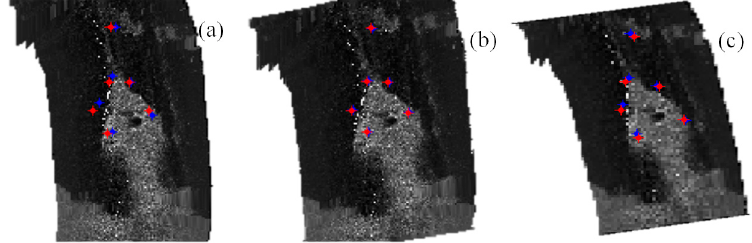
Figure 14. Comparison of the wrapped images using the TPS and the rigid transform. ( a ) Raw SSS image; and ( b , c ) corrected images using the TPS and rigid transformation, respectively. The blue and red points denote the feature points in the SSS image and the MBES image.